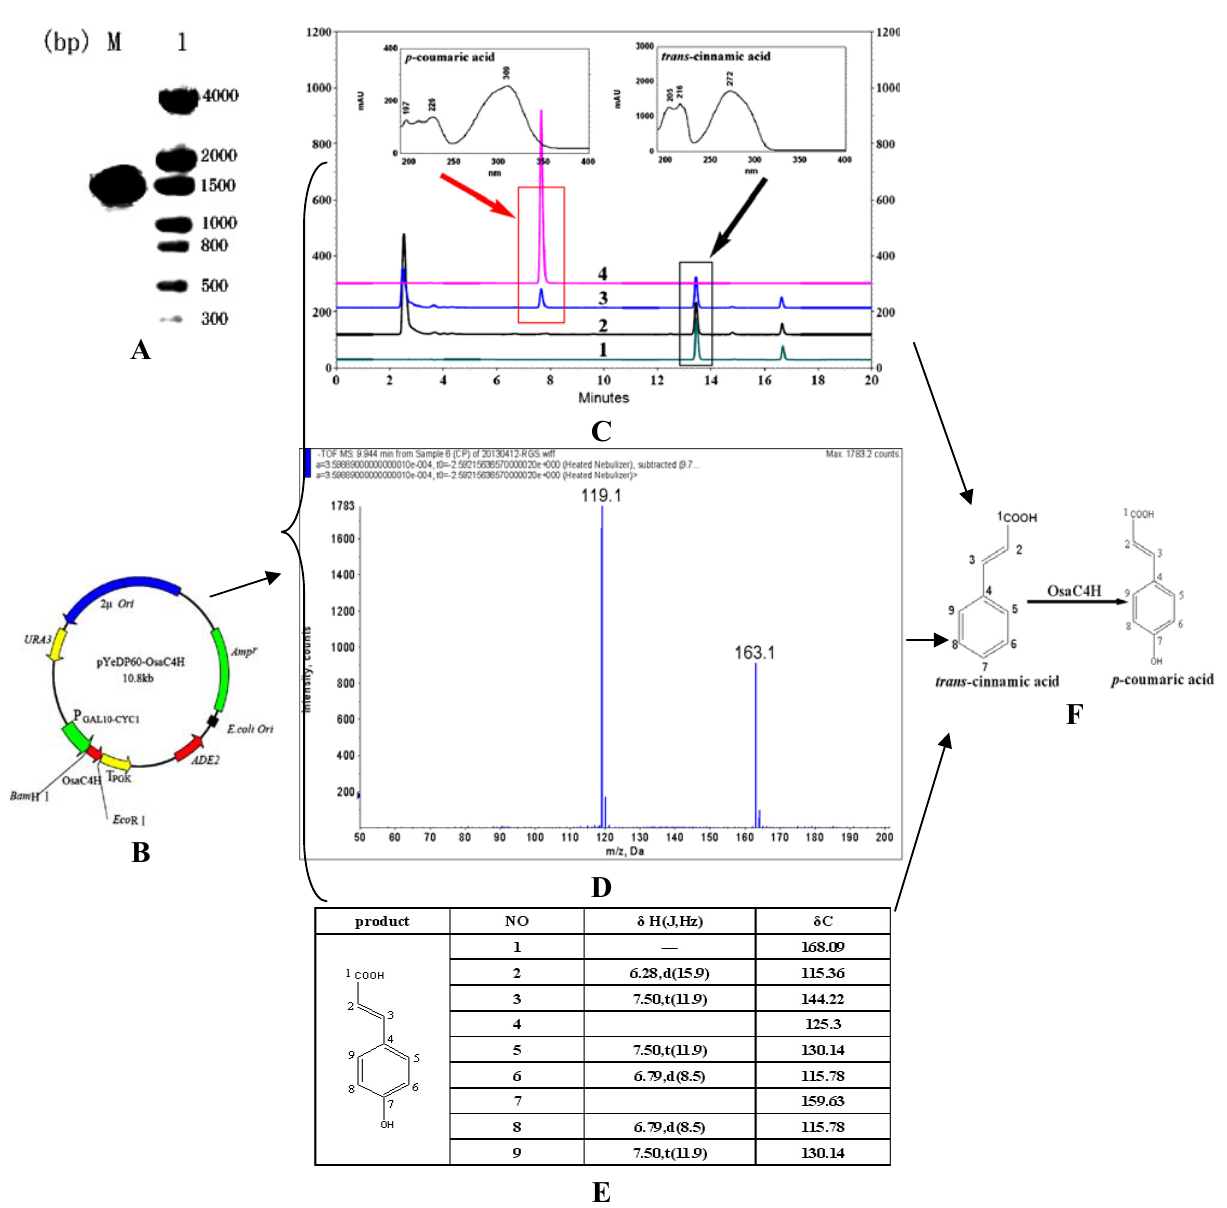
Figure 3. ( A ) Nested PCR analysis of OsaC4H gene (1). M represents DNA molecular marker DL2000. ( B ) The plasmid map of pYeDP60-OsaC4H. ( C ) HPLC analysis of reaction products from WHT[pYeDP60OsaC4H] (3) and WHT[pYeDP60] (2) using trans -cinnamic acid as the substrate. 1 and 4 refer to HPLC analysis results of standard trans -cinnamic acid and p -coumaric acid, respectively. Detection was set at 309 nm. ( D ) ESI-MS of p -coumaric acid in negative mode with singly charged pseudomolecular ion [M − H] at m/z 163.1. ( E ) Two-dimensional 600 MHz spectra of the product from trans -cinnamic acid catalyzed by OsaC4H. ( F ). Hydroxylation of trans -cinnamic acid to p -coumaric acid catalyzed by